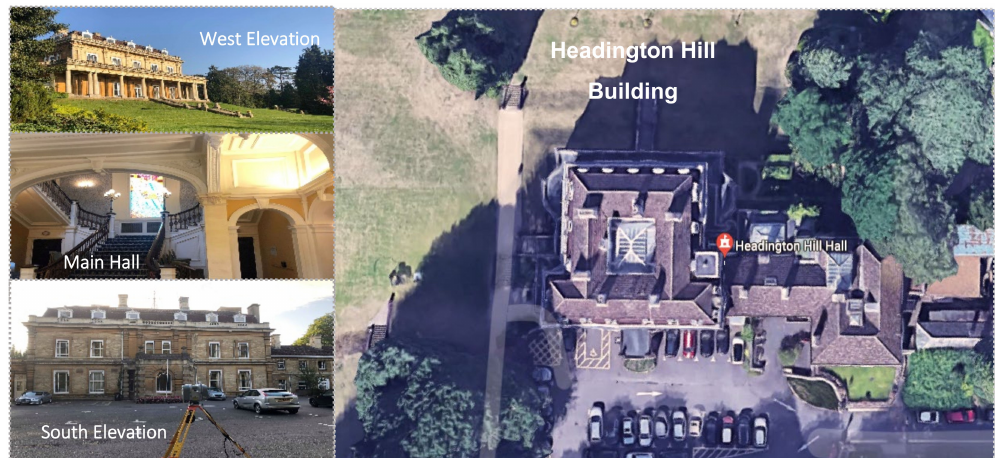
Figure 3. 3D model and aerial view of Headington Hill Building.